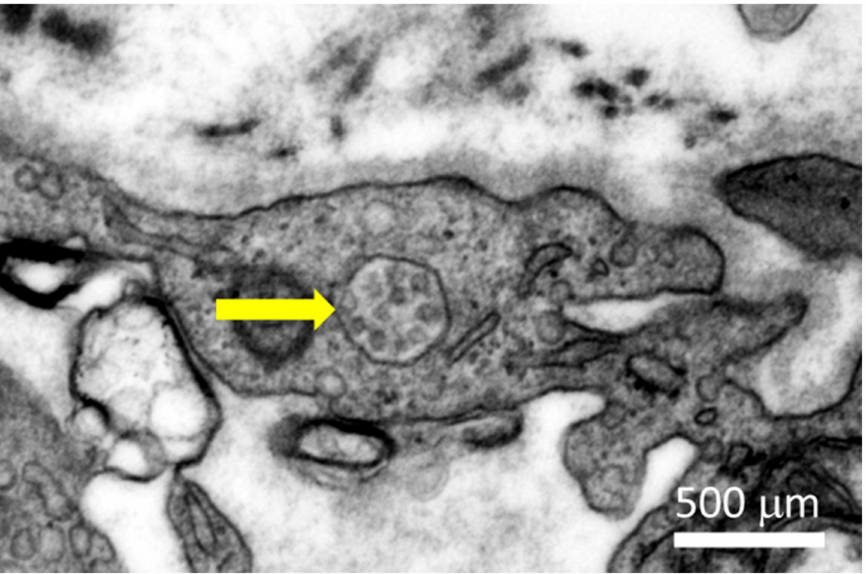
Figure 1. SARS-CoV-2 viral particles in an endothelial cell of the heart of a 64-year-old male COVID- 19 patient. The yellow arrow indicates viral